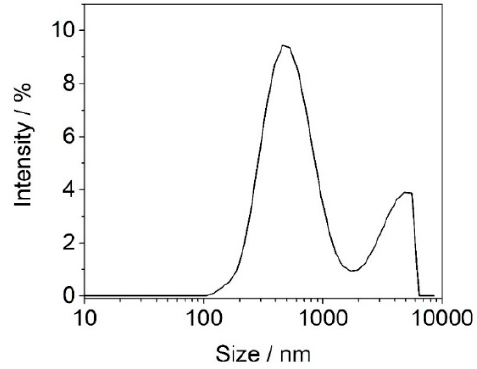
Figure 4. Size distribution of clay particles.